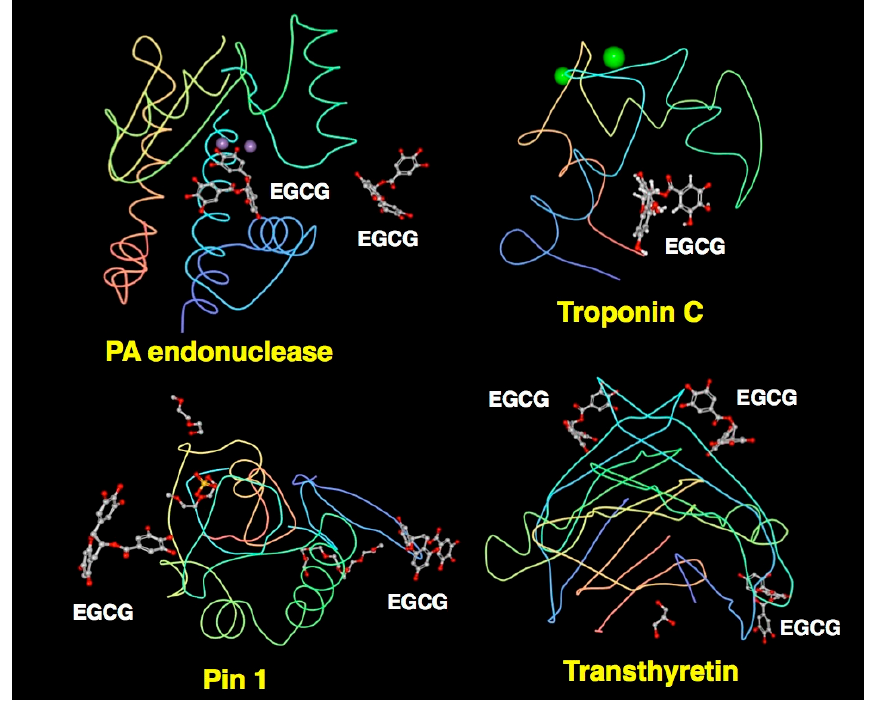
Figure 11. EGCG-binding to the surface of proteins. XCA of the interaction with PA endonuclease, troponin, Pin 1, and transthyretin. Figures are prepared using RCSB PDB Ligand Explorer software.